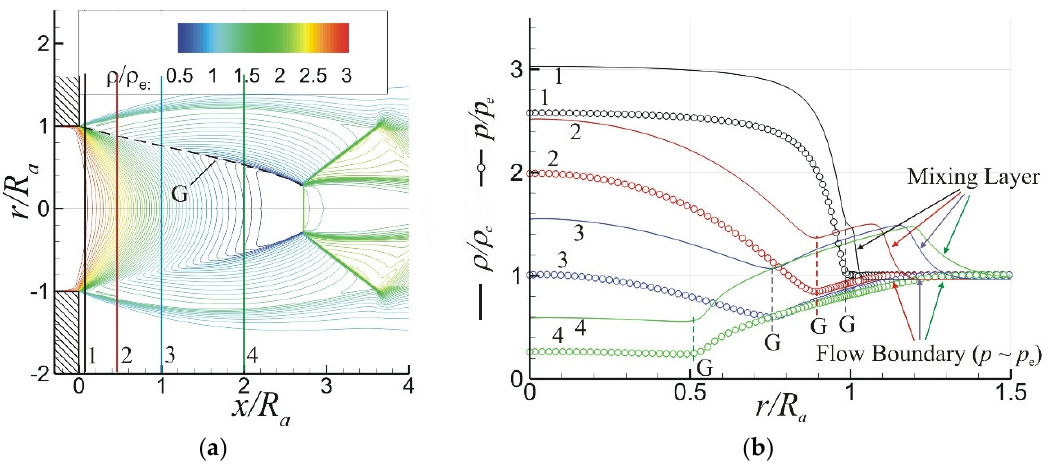
Figure 9. Distribution of Mach-number isolines ( a ) and profiles ( b ) of the relative values of static pressure p/p e and density ρ/ρ e in the sections x/R a = 0.07 (1), 0.5 (2), 1.0 (3), and 2.0 (4) of the first barrel of the jet along the transverse coordinate r/R a .